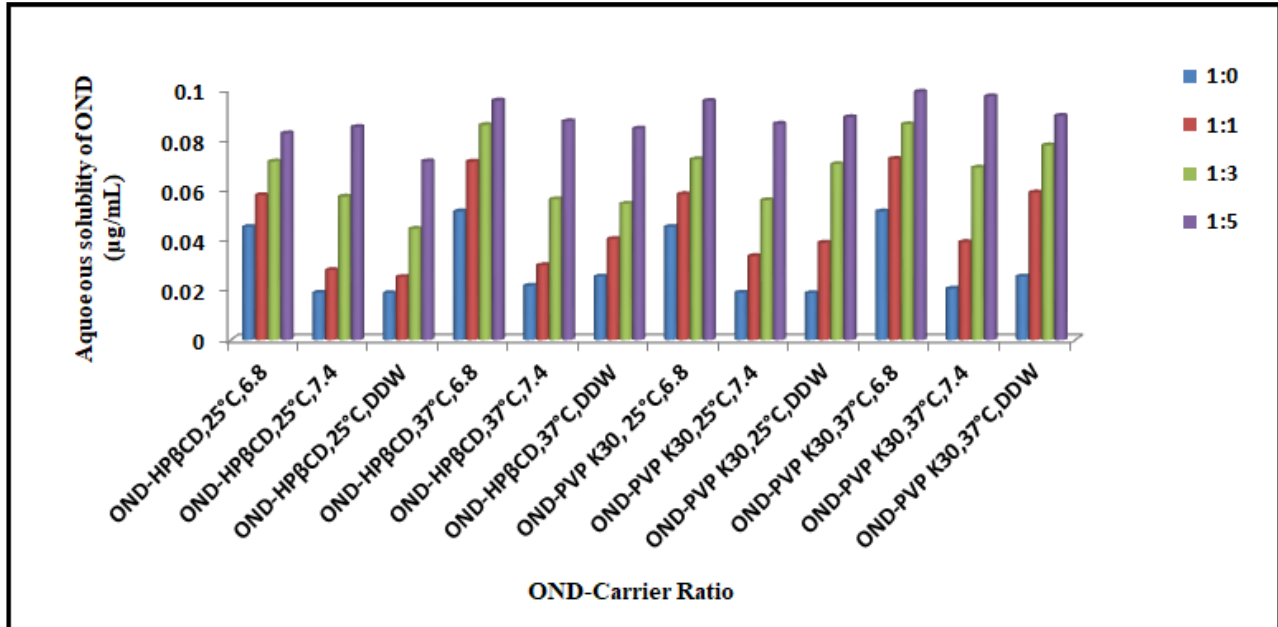
FIGURE 2 - Aqueous solubility of OND in different pH at 25 and 37˚C. The drug content of each binary system (1:1, 1:3 and 1:5 w/w) was found 4845±3, 2412.72±3.4, 1520±8.7 µg/mL and 4772.72±4.5, 2472±1.1, 1527±8.3 µg/mL respectively for HPβCD and PVP K-30. The data of solubility study